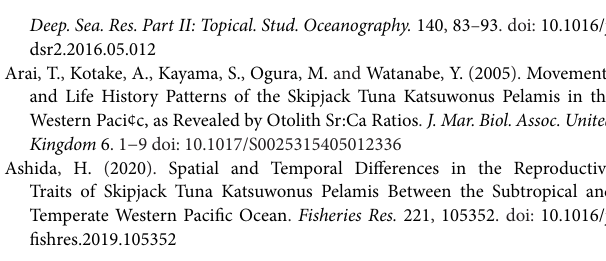
Supplementary Figure 1 | The composition of skipjack tuna catches in the pacific from 1950–2019 (FAO). The different colors represent the catch in six major fishing areas. Supplementary Figure 2 | Timeseries variations of skipjack tuna effort (days) during 1972–2019. Supplementary Figure 3 | The optimal embedding dimensions of the time series. Supplementary Figure 4 | The identification and quantification of nonlinearity of the time series. Supplementary Figure 5 | The nonlinearity tests of the first-differenced indices (NPGOfd, PDOfd, SOIfd). The first row represents the optimal embedding dimensions of climate indices at the state space level; the second row represents the identification and quantification of nonlinearity of climate indices. Supplementary Figure 6 | The CCM results between CPUEda and climate indices (NPGOfd, ONI, PDOfd). Blue lines represent the climate indices effect on CPUE. Supplementary Figure 7 | Graphical residuals exploration results for the model during the first era (1972−1991). Supplementary Figure 8 | Graphical residuals exploration results for the model during the second era (1992–2019). Supplementary Table 1 | Linear Correlations between SKJ CPUEda and climate indices during 1972–2019. *means coefficients significant at